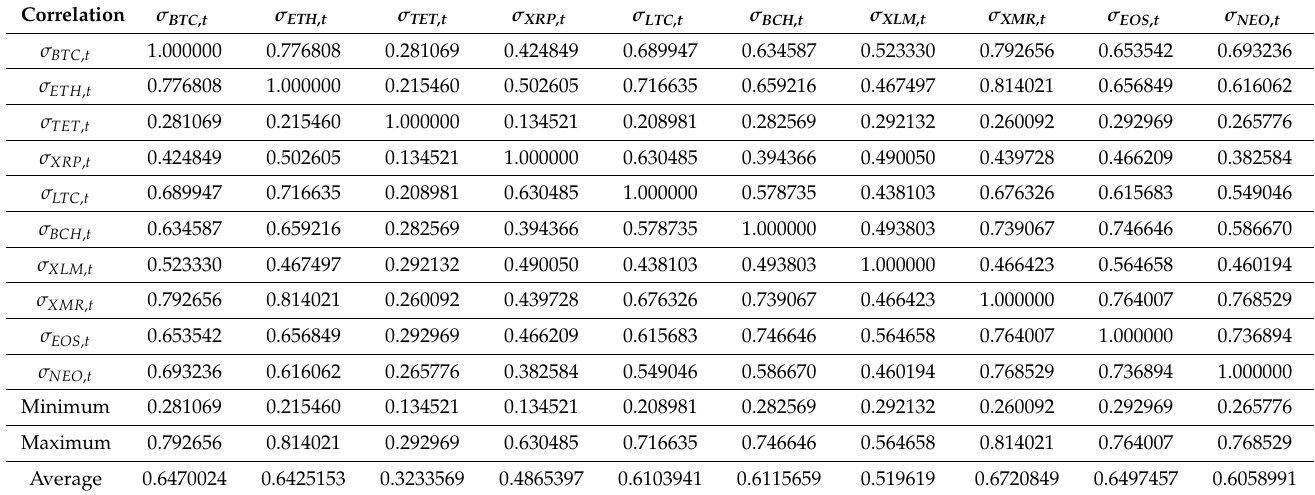
Table 10. Correlations among the varying GARCH values of the 10 cryptocurrencies’ return indices for the full period.